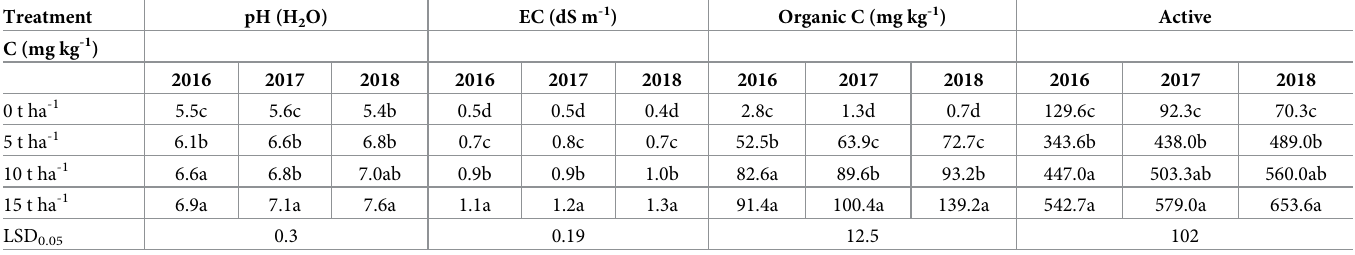
Values followed by the same letter in a column are not significantly (P < 0.05)